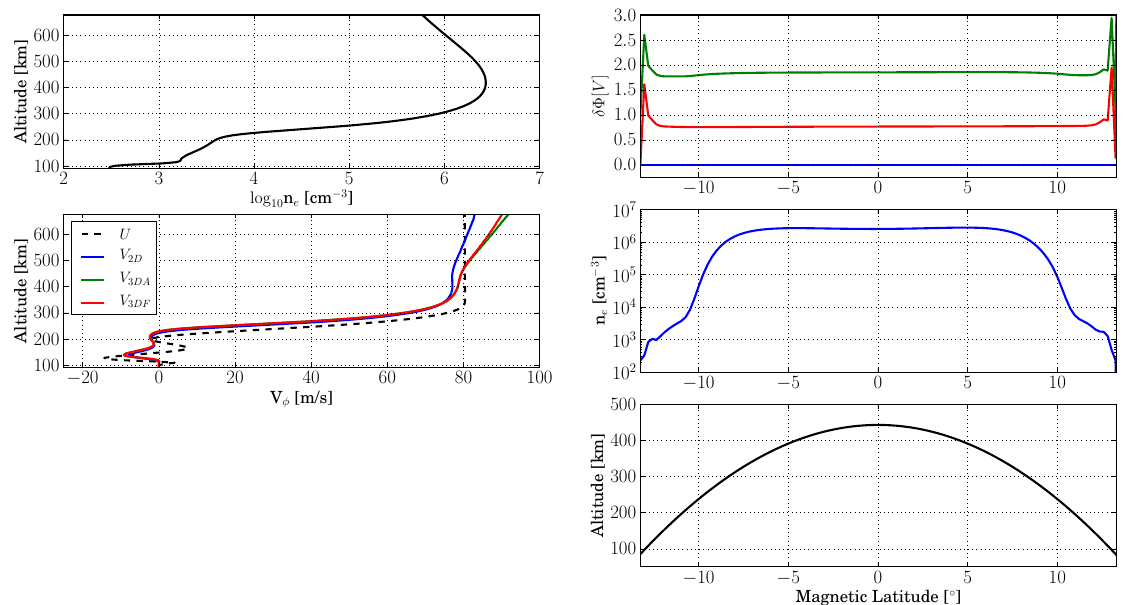
Figure 1. Initial conditions for the ESF model run ( t = 19:00 LT) at φ =0. (Left) Vertical cut: (top) plasma density and (bottom) zonal plasma drifts for (blue) 2D, (green) 3D-A, and (red) 3D-F electrostatic models. (Dashed) Local zonal wind speeds are also depicted for reference. (Right) Cut through the meridional plane at 440 km apex altitude : (top) electrostatic potential, (middle) plasma density, and (bottom) equivalent altitude.